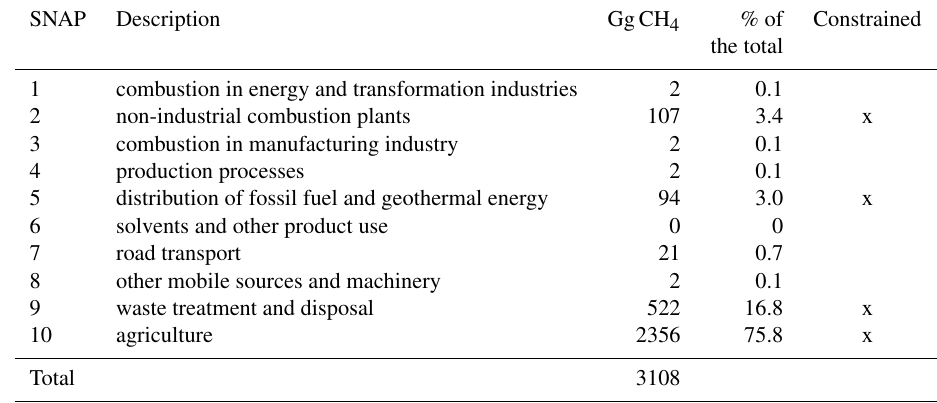
Table 2. Prior yearly total methane emissions (in GgCH 4 ) in France from IER interpolated on the model’s grid; the crosses (x) indicate sectors which are constrained by the atmospheric inversion (in the sectorial run). SNAP Description GgCH 4 % of Constrained the total 1 combustion in energy and transformation industries combustion in manufacturing